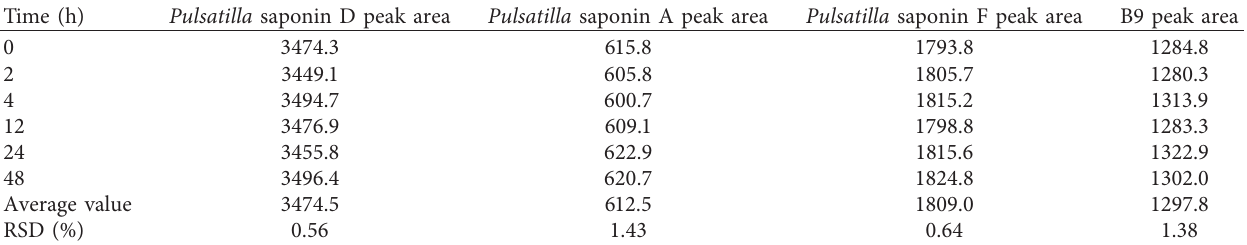
Table 6: The results of stability.